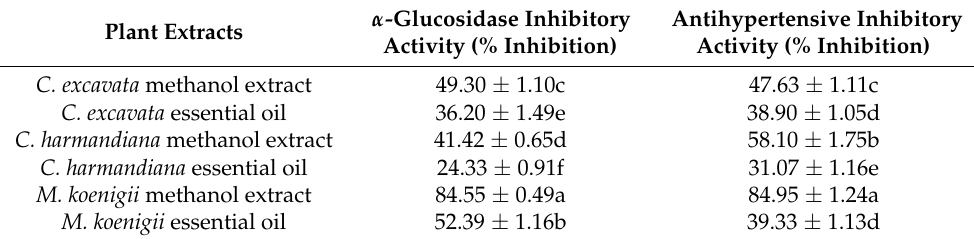
Table 4. Alpha- glucosidase and antihypertensive inhibitory activity of methanol extract and essential oil of Clausena excavata , Clausena harmandiana and Murraya koenigii